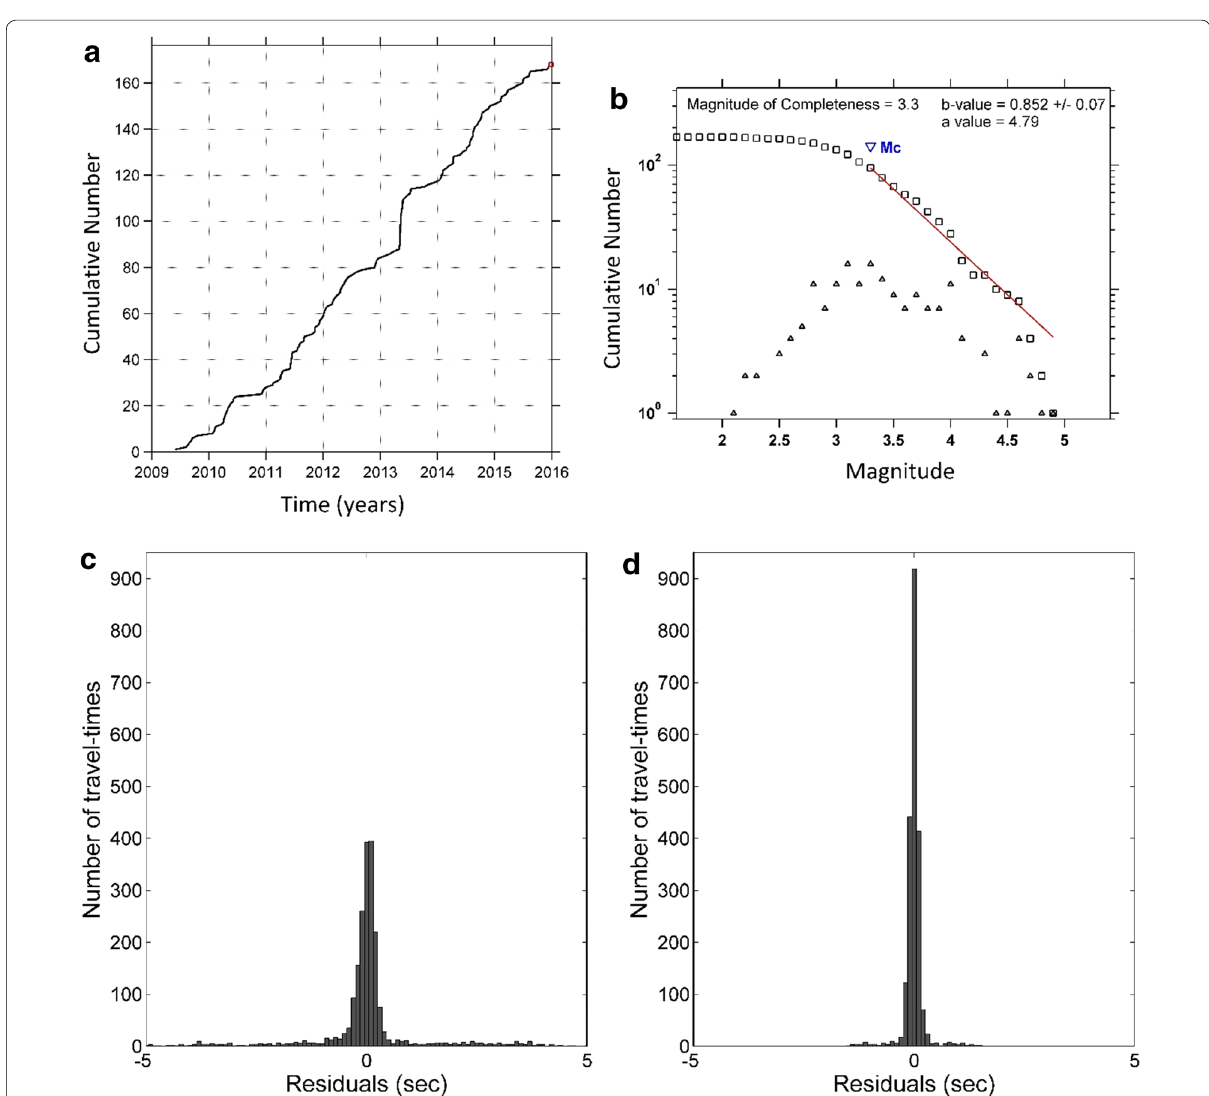
Fig. 3 a Earthquake cumulative number, b earthquake magnitude–frequency relation (Gutenberg–Richter law) for 168 initial